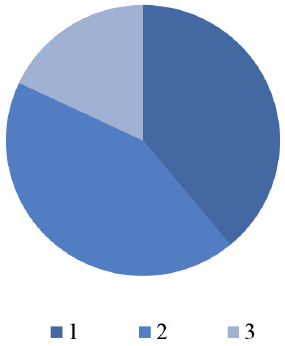
Figure 5 Attitudes to consumer properties of enriched breads: